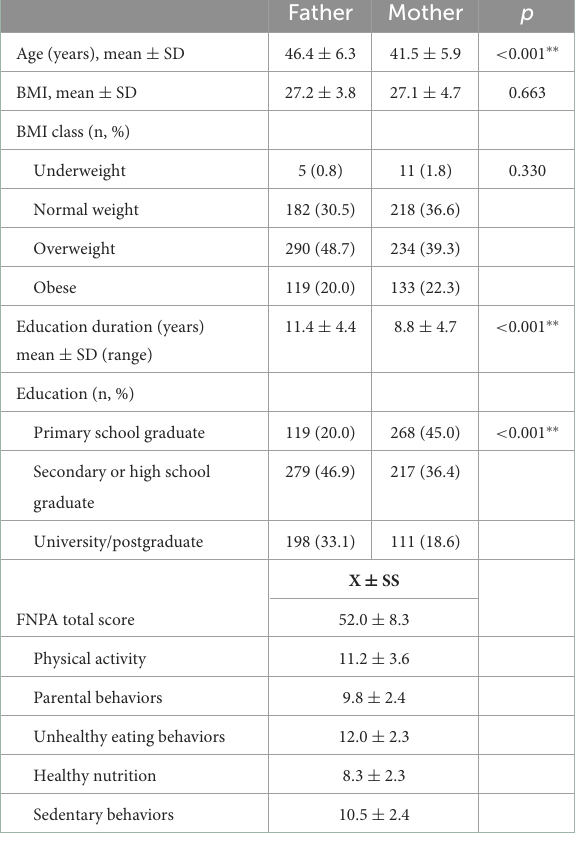
TABLE 1 Descriptive characteristics of the parents, FNPA total and subscales scores ( n = 596).